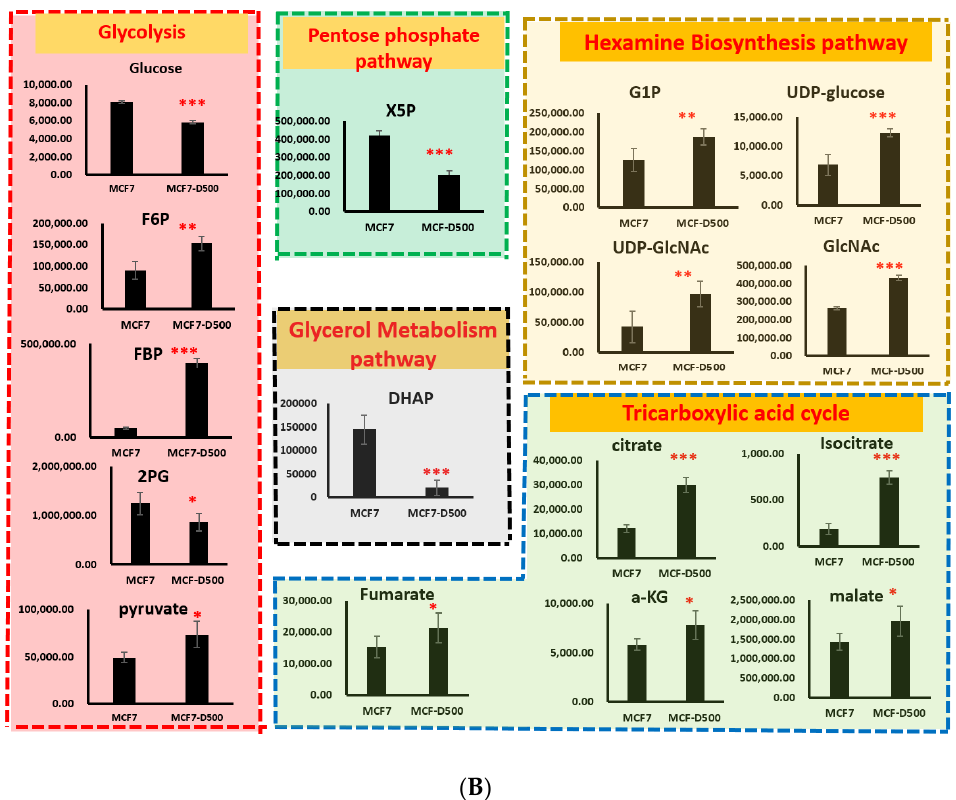
Figure 4. Schematic of metabolic pathways involved in MCF-7 cells with drug resistance. ( A ) Overview of changes in metabolic products in integrated energy metabolism pathways. The green frame indicates the pentose phosphate pathway. The red frame indicates the glycolysis pathway. The gray frame indicates the glycerol metabolism pathway. The green frame indicates the TCA cycle. The yellow frame indicates the hexamine biosynthesis pathway, and the blue frame indicates the amino acid metabolic pathway. Red arrows indicate metabolic products upregulated in the MCF-7-D500 cells, and green arrows indicate downregulated metabolic products. ( B ) The expression levels of metabolites significantly differed between the MCF-7 and MCF-7-D500 cells in their respective pathways. (* p < 0.05; ** p < 0.01, *** p < 0.001).